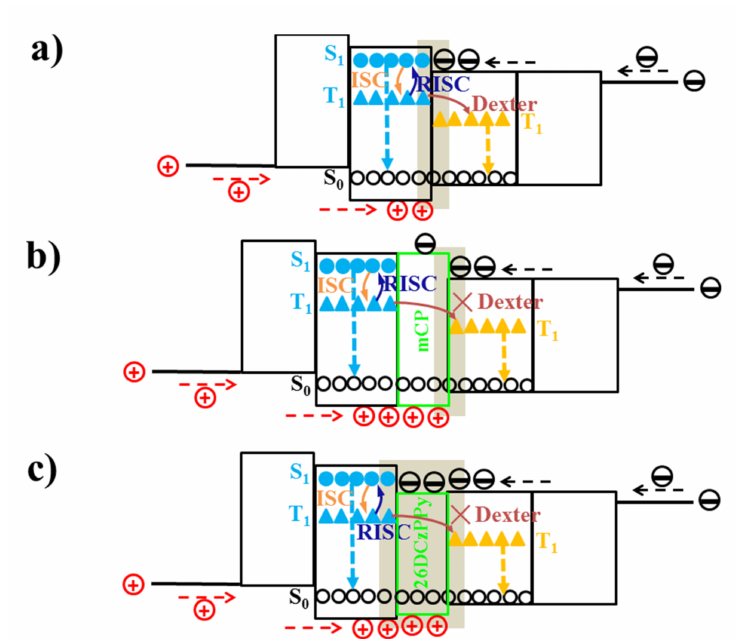
Figure 11. Schematic illustration of the working mechanism of ( a ) W11; ( b ) W12 and ( c ) W13. The gray filled rectangles are the main exciton generation zones. The Dexter energy transfer can occur in W11, while it is prohibited in both W12 and W13. Reproduced with permission from [155], Elsevier, 2017.